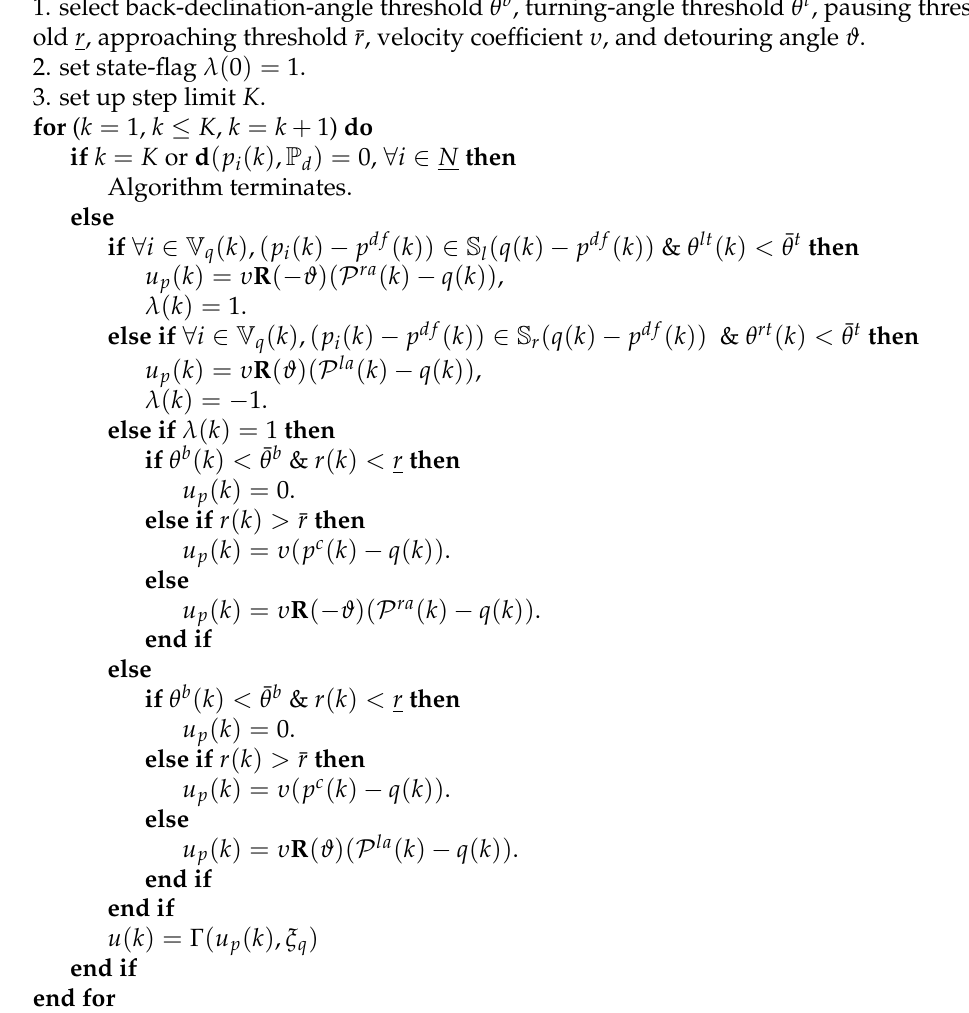
Algorithm 4 Herding Algorithm With Dynamic Far-end and Pausing